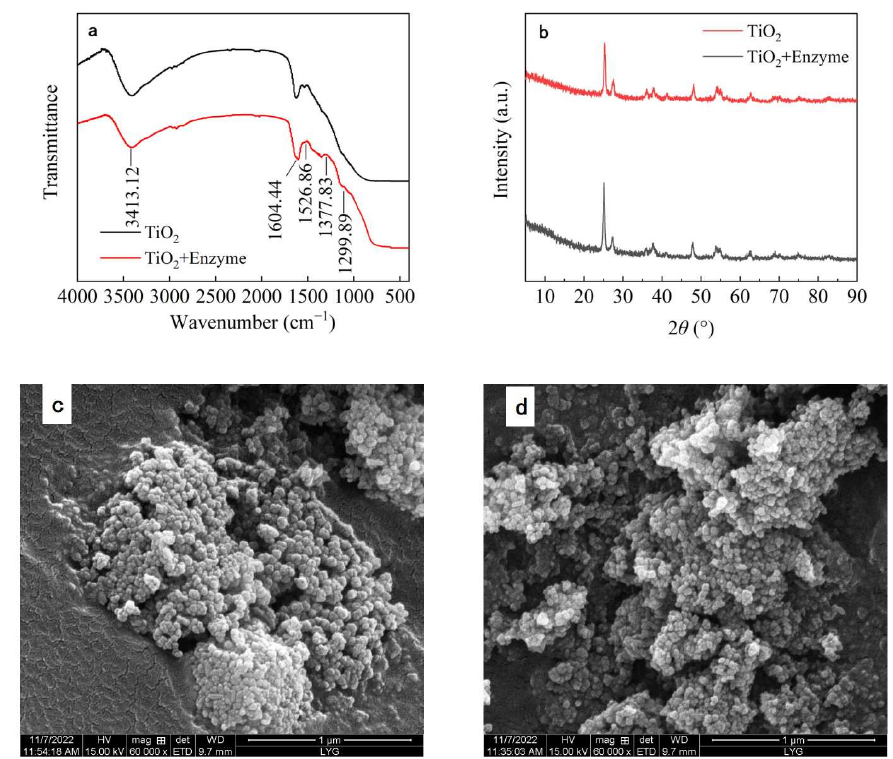
Figure 5. ( a ) FT-IR spectrum of the immobilized enzyme, ( b ) XRD patterns of the immobilized enzyme, ( c ) FEG-SEM images of TiO 2 , ( d ) FEG-SEM image of immobilized dextranase. Table 1. Analysis of the ratio of the hydrolysates of